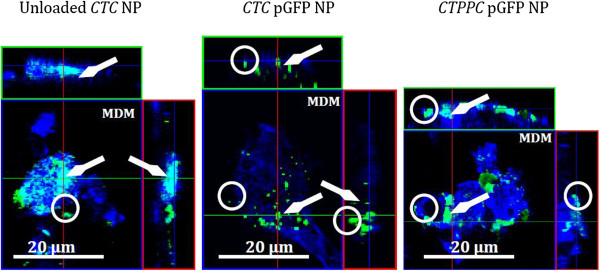
CLSM micrographs of phagocytosed NP (green) by MDM (blue). The pictures represent single optical sections; the red line indicates the optical section of the YZ projections (right image) and the green line the XZ projections (upper image). XY and XZ-projections clearly indicate that NP are mainly taken up by MDM (arrow). Extracellular NP are encircled. The horizontal bar represents 20 μm.